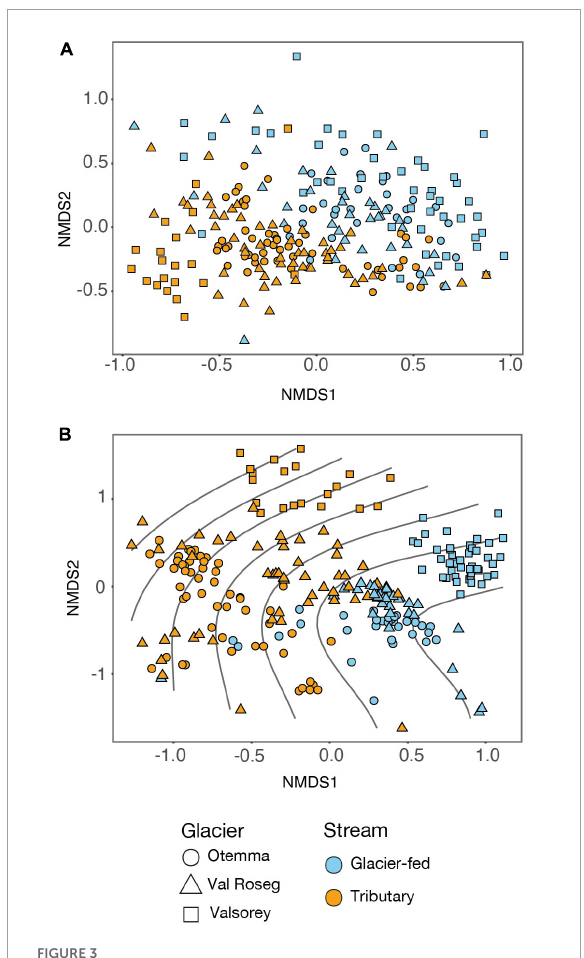
FIGURE3 Patterns of bacterial community structure in glacier floodplains. Sample ordination is a non-metric multidimensional scaling (NMDS) based on Bray-Curtis dissimilarity for (A) 18S rRNA (stress value: 0.24) and (B) 16S rRNA (stress value: 0.19). Colors indicate the two-stream types, and symbol shapes specify the three glacier floodplains. Smooth response curves in panel B were obtained from site scores (first NMDS axis) of phototrophic 18S NMDS and indicate that the differences in prokaryotic community similarity between stream types were also associated with changes in phototrophic eukaryotic community similarities.